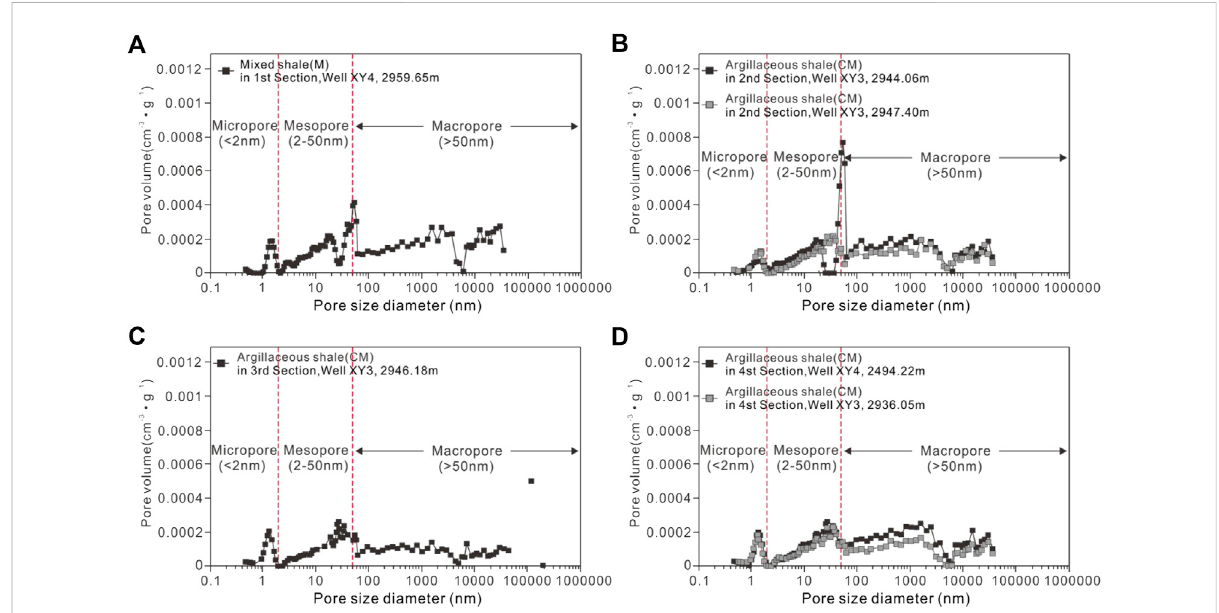
FIGURE 7 Pore-size distributionofdifferentshale lithofacieswithMICP andLTNA fortheJurassic Dongyuemiao lacustrineshaleinEasternSichuan